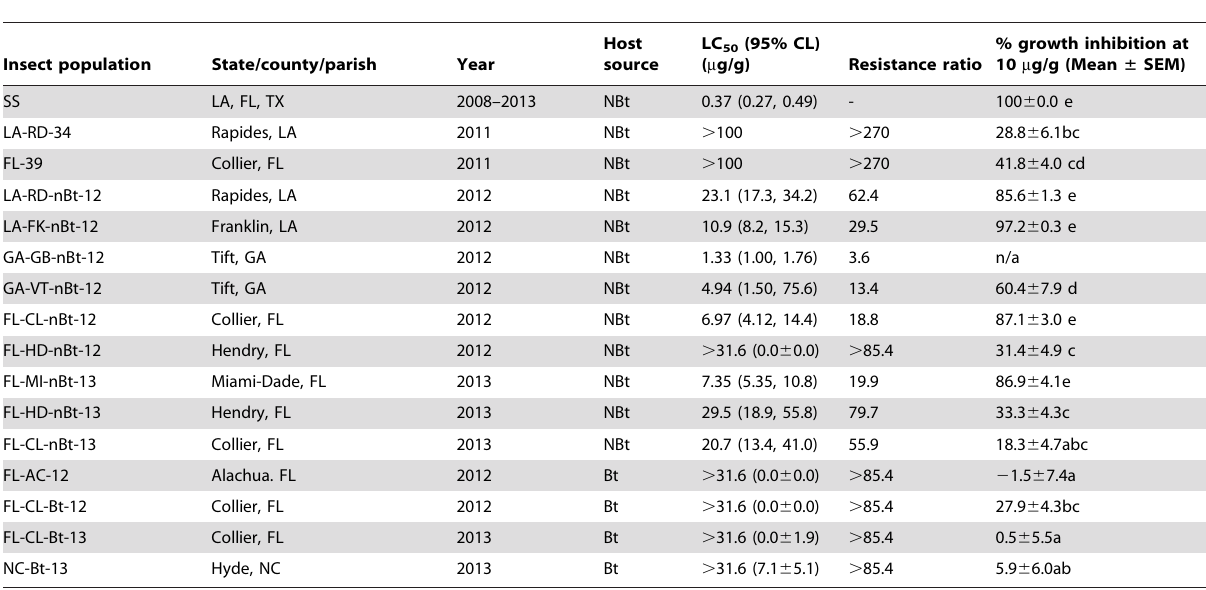
Table 2. Susceptibility of Spodoptera frugiperda collected from multiple locations to purified Cry1F protein using diet-incorporated